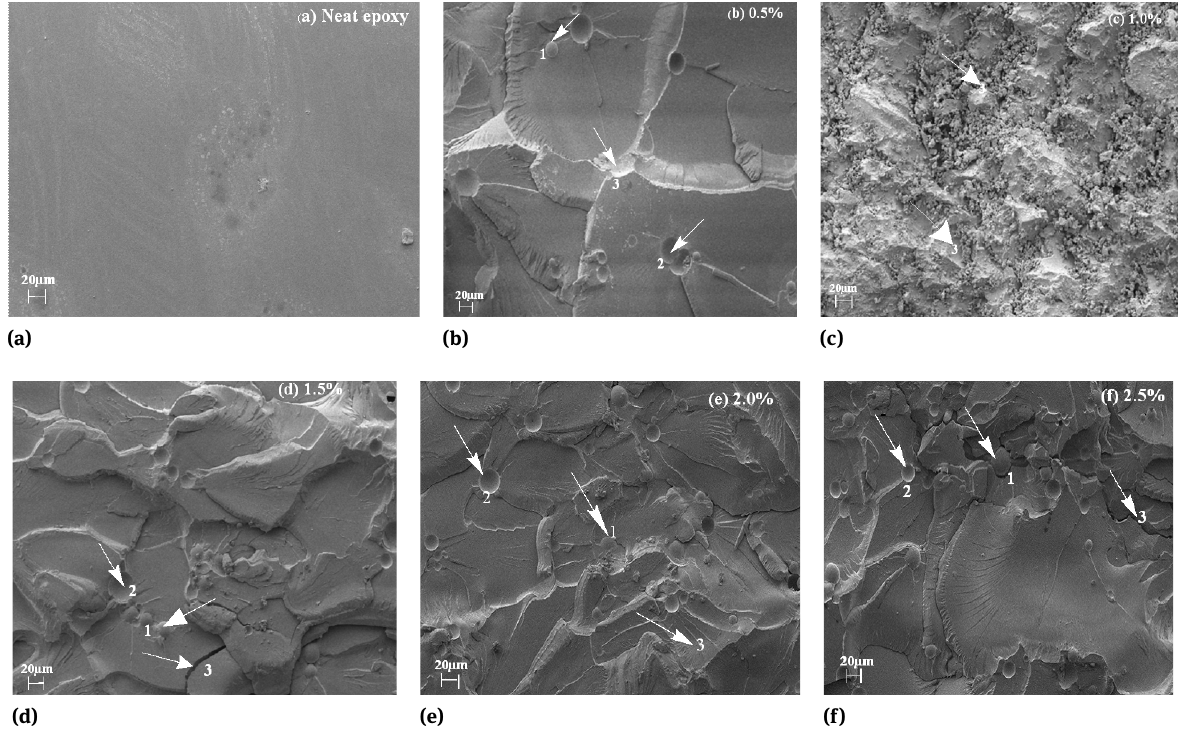
Figure 4: SEM images for tensile fracture surfaces for (a) neat resin and (b-f) percentage fraction of HGM 0.5-2.5% in syntactic foam at 500 magnifications showing the arrowed areas as 1: deboned microspheres, 2: fractured microspheres and 3: fractured